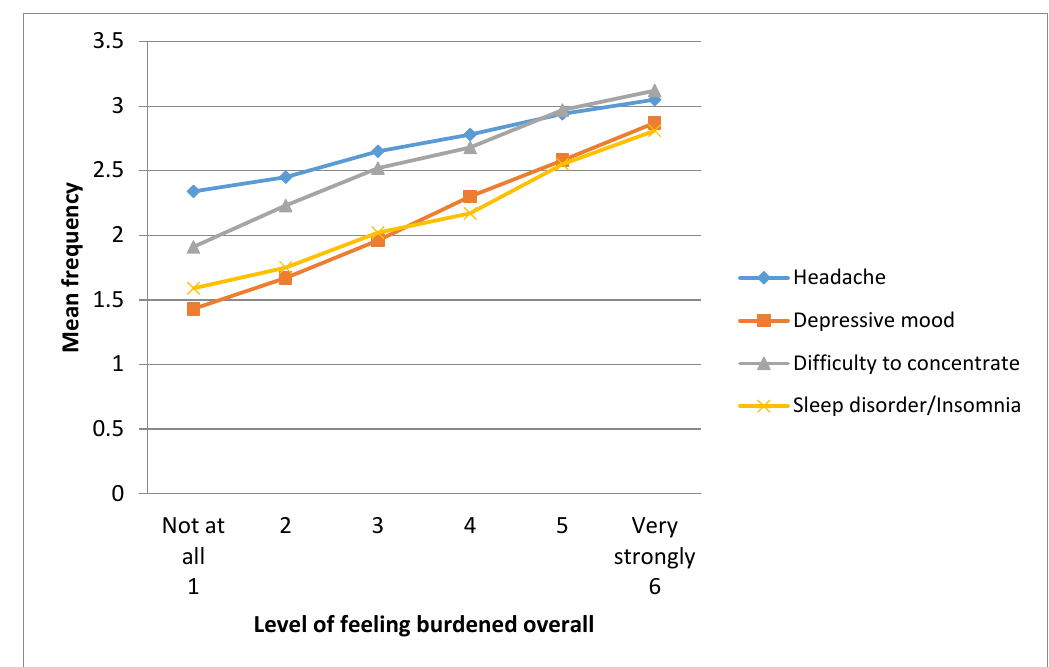
Figure. 1. Mean frequency of headache, insomnia, difficulties to concentrate and headache by level of feeling burdened